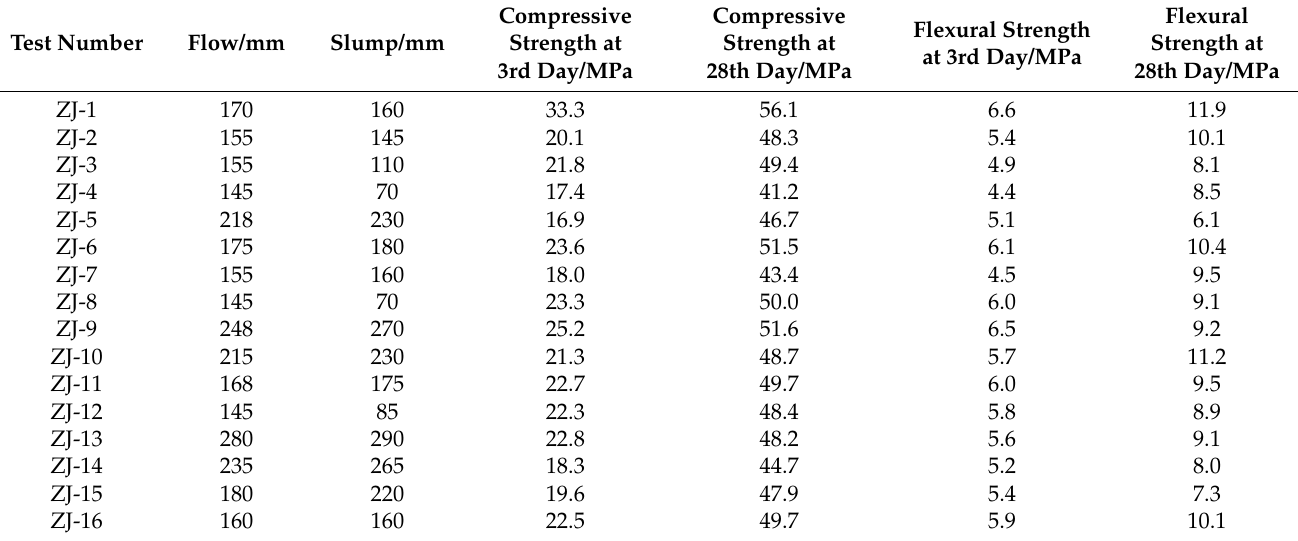
Table 7. Orthogonal test results.